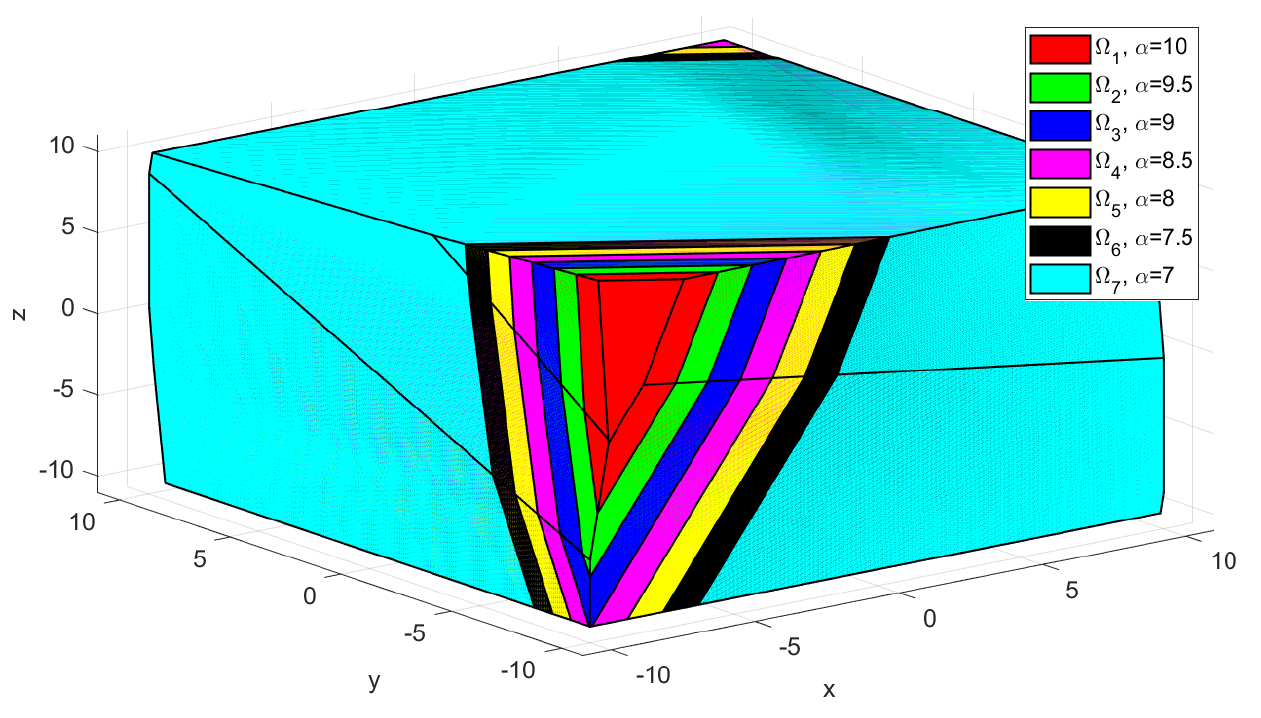
Figure 3. Case 2—Depiction of the predefined invariant sets corresponding to sub-system S 1, com- puted for uncertainty constraint limit value β =